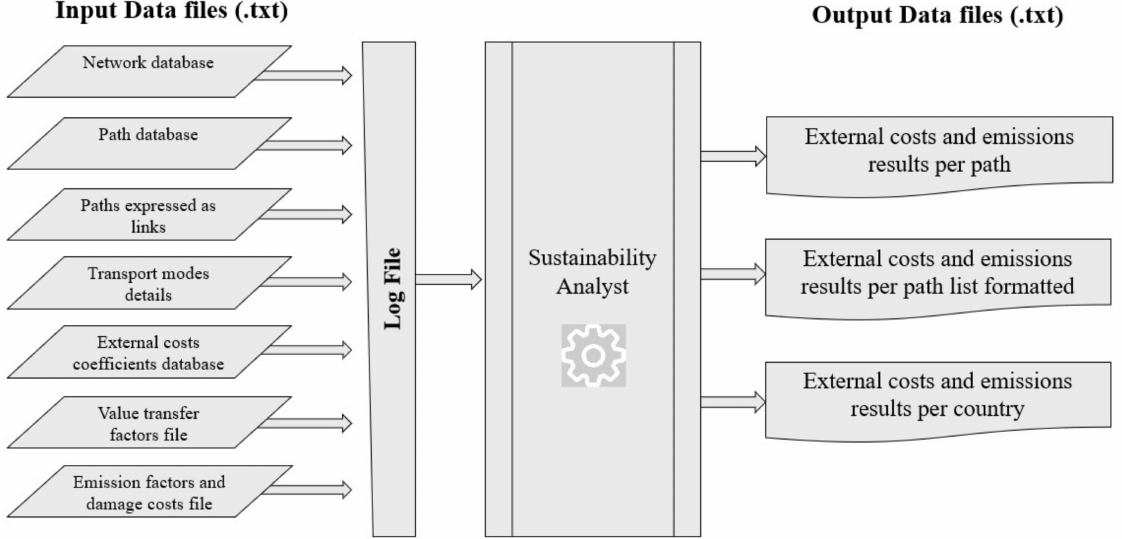
Figure 1. Data flowchart of the software Sustainability